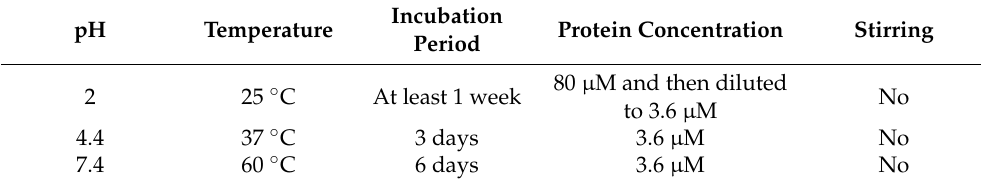
Table 1. Experimental conditions of three TTRwt aggregation protocols.